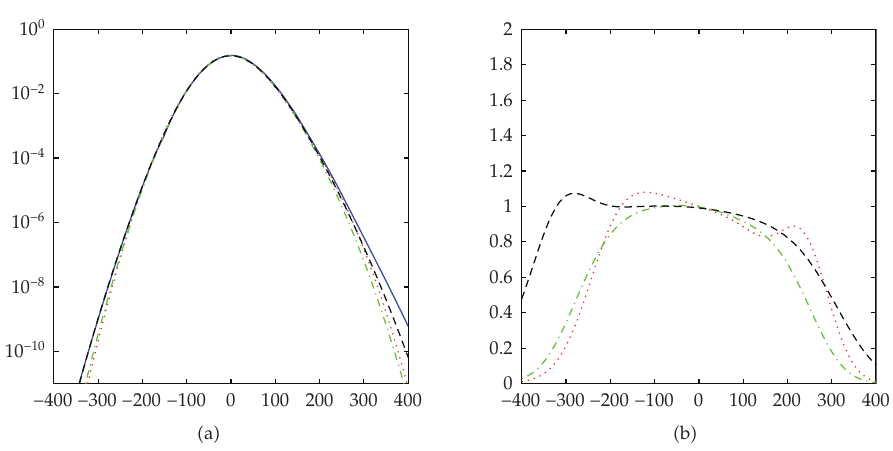
(cid:2) s,t (cid:3) computed using the proposed hybrid method: N (cid:2) u (cid:3) /μ s (cid:2) u (cid:3) . N